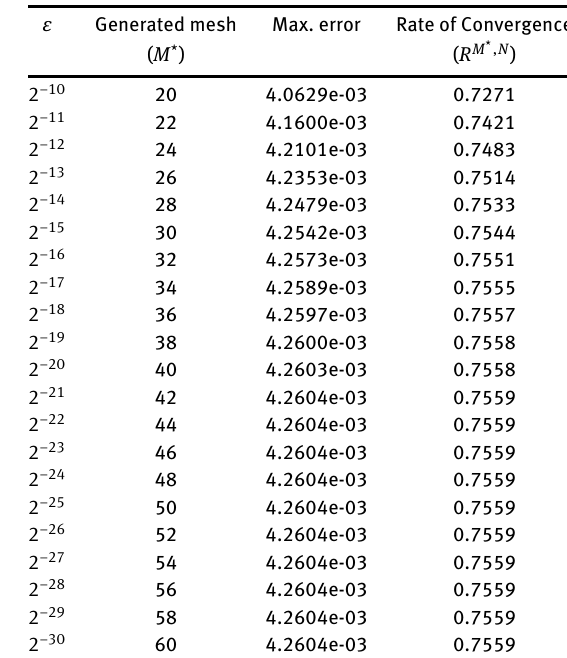
Table 5: Maximum point wise errors of the solution and correspond- ing rate of convergence for Example 5.3 by taking δ = 0.1 , η = 0.2 , M=10 and N=20 for different values of ε